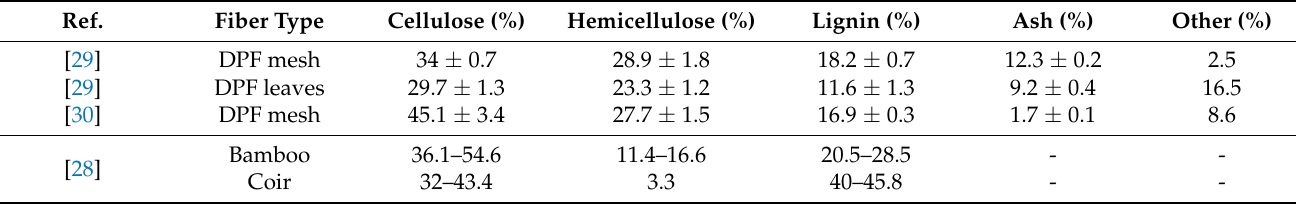
Table 1. Chemical composition of DPF.